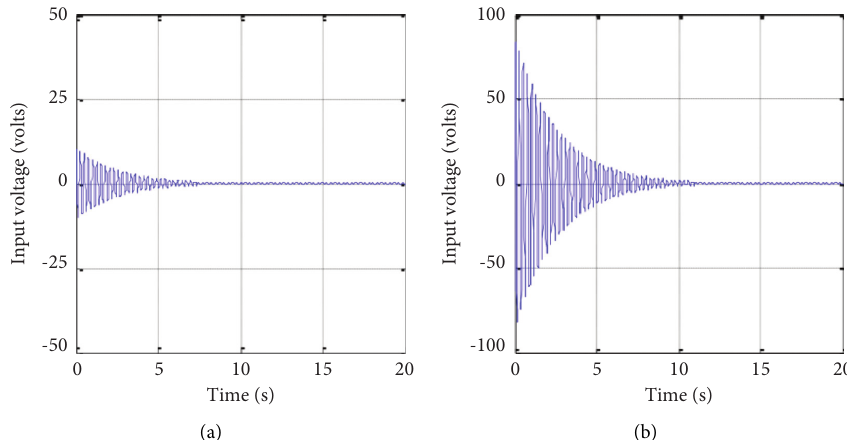
( t ) and V ( t ) . (a) Voltage V ( t ) applied to the first pair of piezoelectric actuators. (b) Voltage V 1 2 1